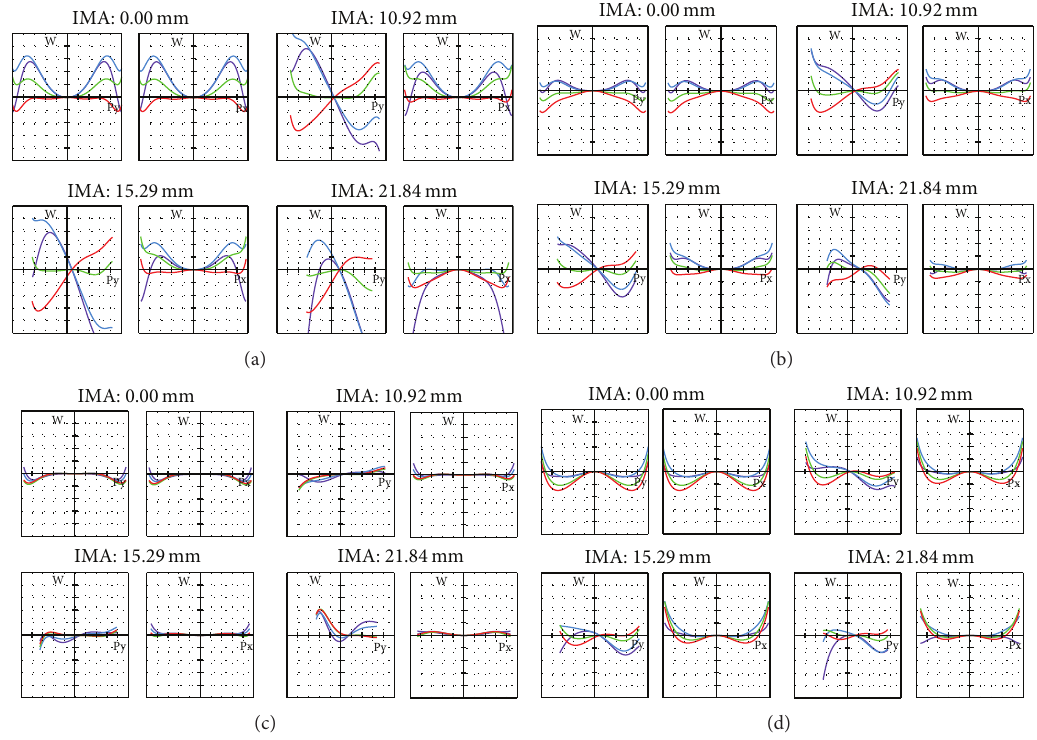
Figure 7: OPD fans for 2-meter object distance: (a) patent data, (b) iteration 1, (c) iteration 2, and (d) iteration 3. Plot scale is 2